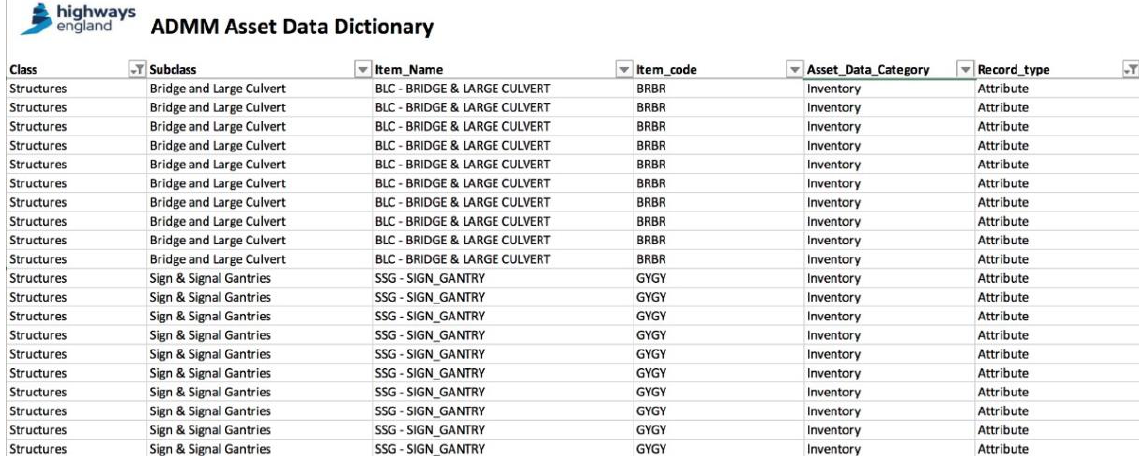
Figure 1: Example of the ADMM Data Dictionary Structure & Hierarchy ADMM Data Dictionary: a Microsoft Excel